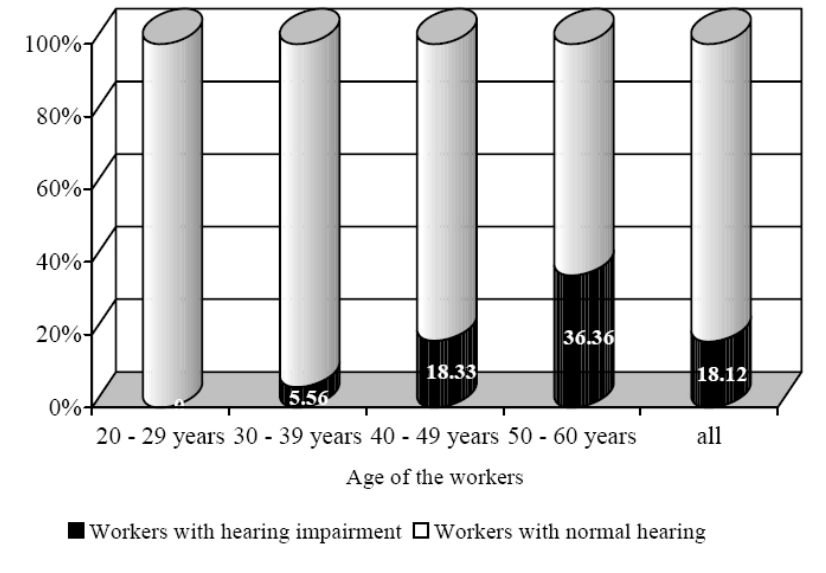
Fig. 2 Rates of cases of hearing impairment in workers exposed to excessive noise de- pending on their